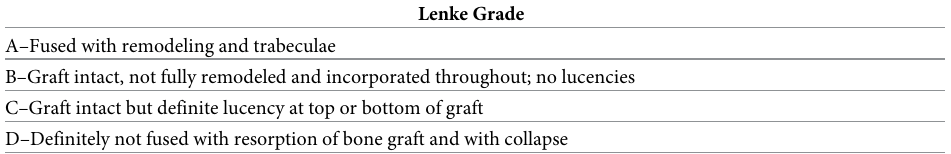
Table 2. Lenke scoring